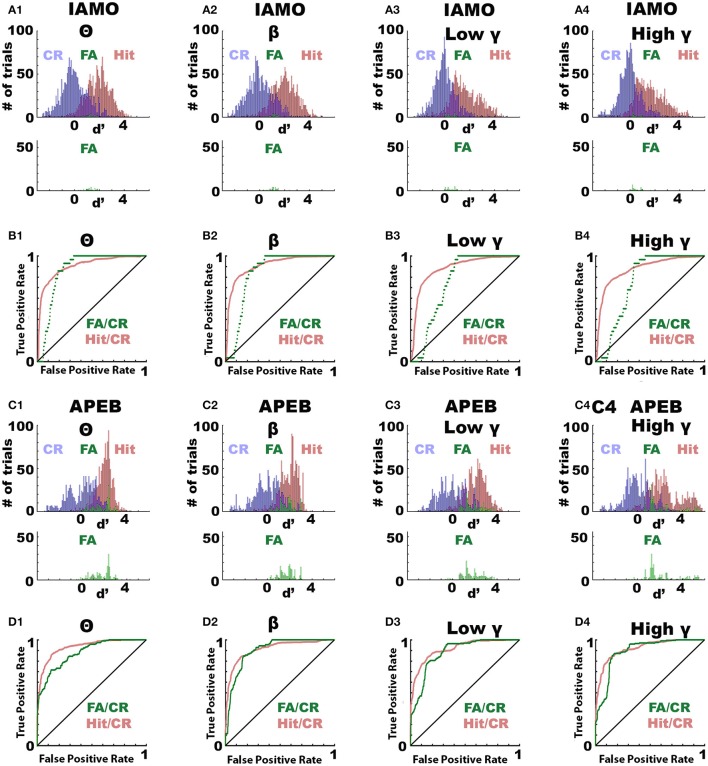
ROC analysis of the odorant-elicited change in LFP power (Δ power) for trials when the animal responds by licking to the unrewarded odorant (false alarm, FA). ROC analysis of the per trial LFP Δ power calculated when the animals were performing >80% correct. ROC was calculated for Δ power calculated in FA trials vs. Δ power calculated in correct rejection (CR) trials where the animal refrained for licking to the unrewarded odorant (FA/CR) or for Δ power calculated in Hit trials where the animal was licking for the rewarded odorant vs. Δ power calculated in CR (Hit/CR). (A,B) IAMO odorant pair, (C,D) EAPA odorant pair. (A,C) Histograms for LFP Δ power in decibels for Hits (red), CRs (blue) or FAs (green). (B,D) ROC analysis for Hit/CR (red) or FA/CR (green). All auROCs were significantly different from the diagonal (p < 0.0001, pFDR = 0.05). auROC significance was tested using the z-test and the p-values were corrected for multiple comparisons by calculating the significance p-value corrected for the false discovery rate (Curran-Everett, 2000).